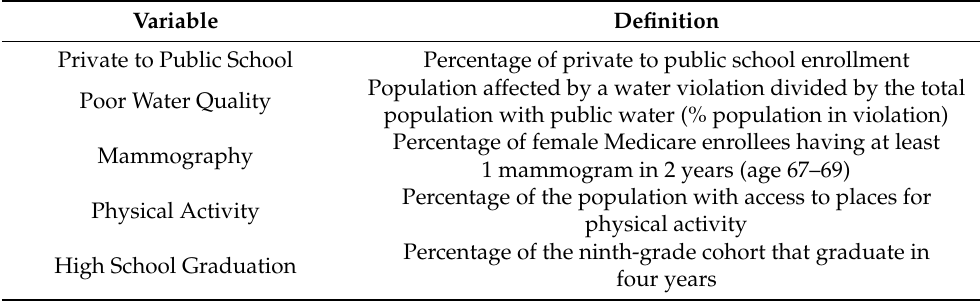
Table A11. Quality/outcomes of public services.